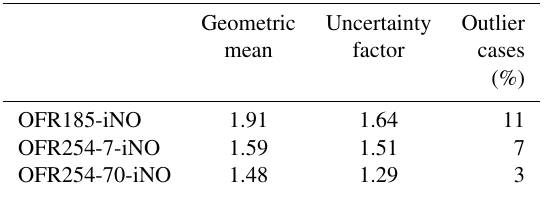
in the model with the Lambe et al. (2011) residence time distribu- tion (OH exp , RTD ) and in the plug flow model (OH exp , PF ). The geo- metric mean, uncertainty factor (geometric standard deviation), and percentage of outlier cases ( > 3 or < 1 / 3) are shown for OFR185- iNO, OFR254-70-iNO, and OFR254-7-iNO. Geometric Uncertainty Outlier mean factor cases (%)